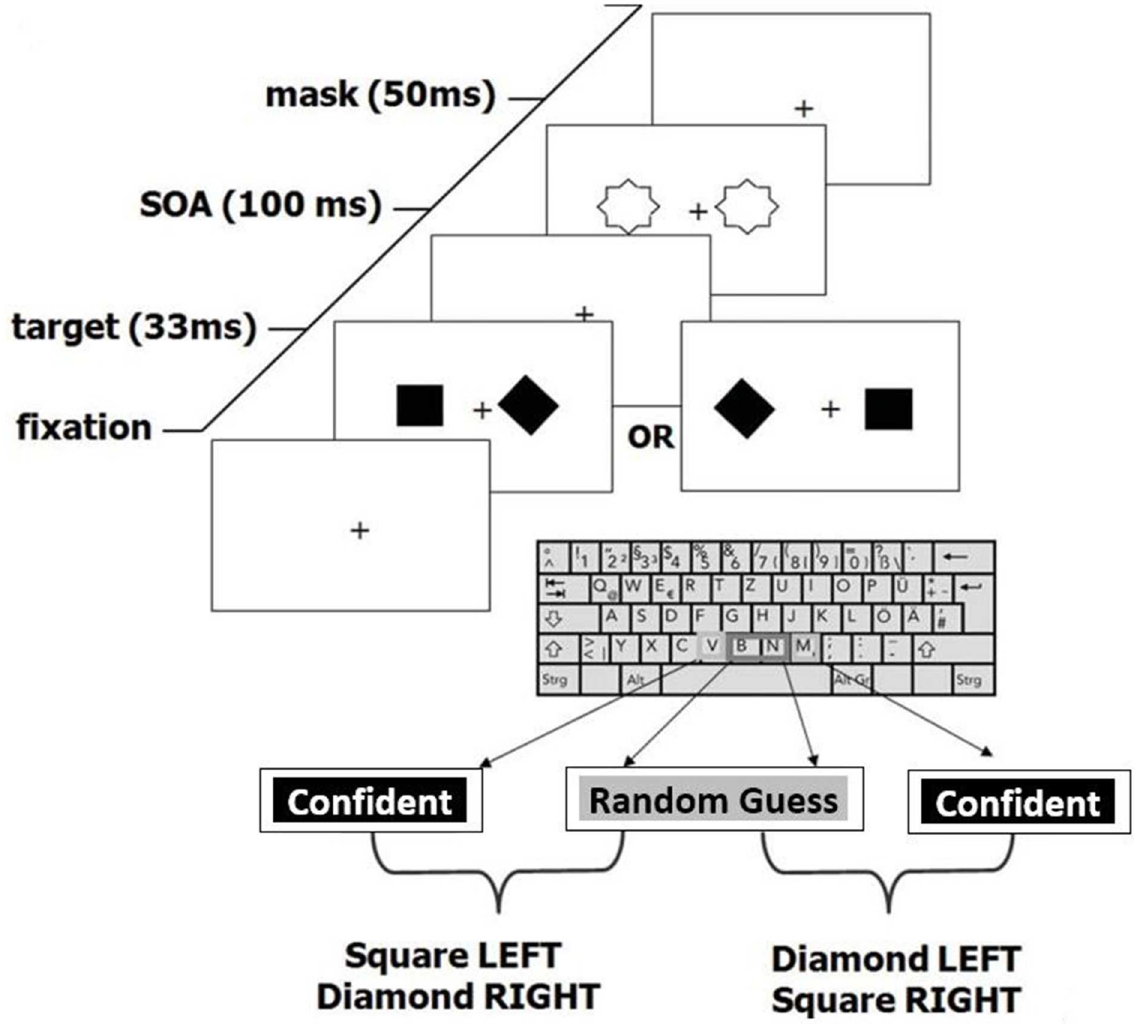
Fig 1. Experimental design. Experimental design was identicalto Rounisand colleagues[19], apart from exceptionsdescribedin methods. Most notably, confidencein choice was used insteadof visibilityto determinemetacognitive judgement. Participantswere presentedwith either a diamondon the left and square on the right or vice versa, followedby a metacontrast mask. They were then requiredto make a combinedjudgement as to the stimulus configuration and their level of confidencein that decision.Adapted from Rounis[19] with